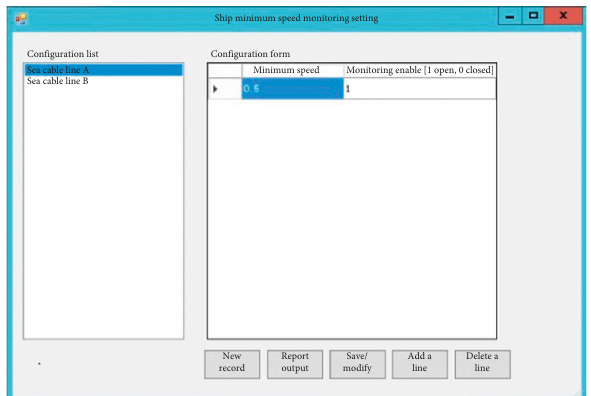
Figure 15: Speed threshold setting